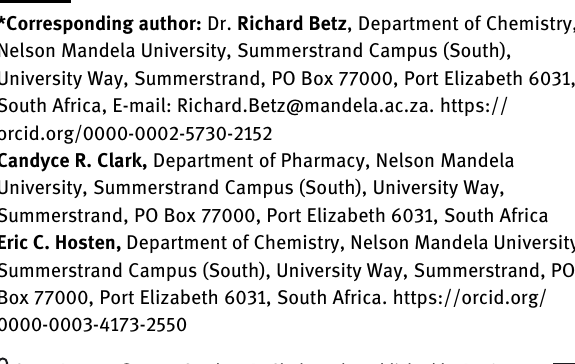
Table 1 contains crystallographic data and Table 2 contains the list of the atoms including atomic coordinates and displacement parameters.